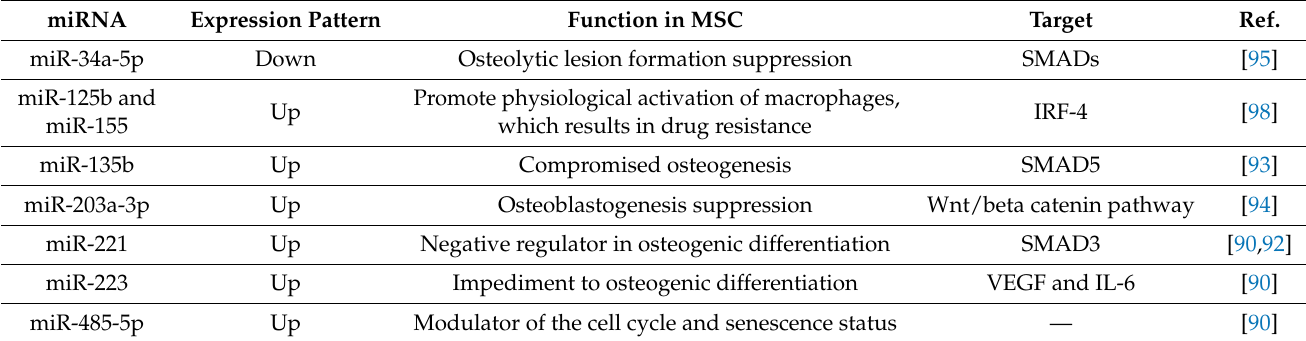
Table 1. The miRNAs related to the MSCs implicated in